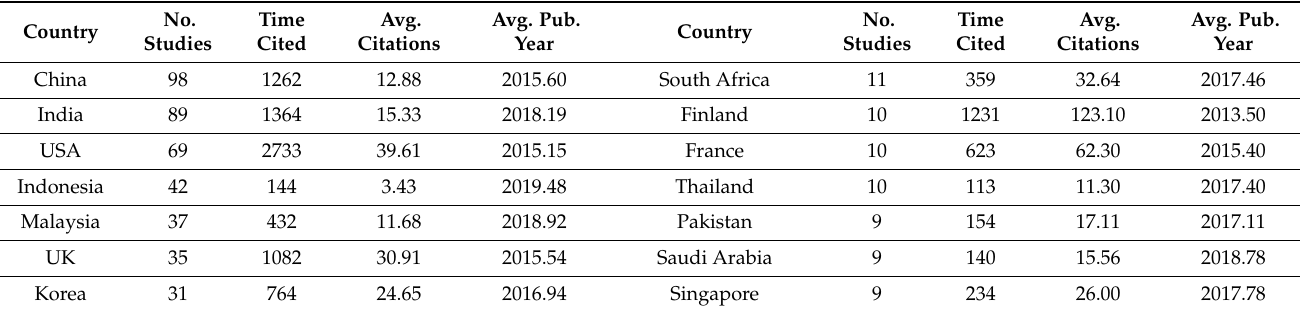
Table 1. Countries contributed to the field of digital payment.